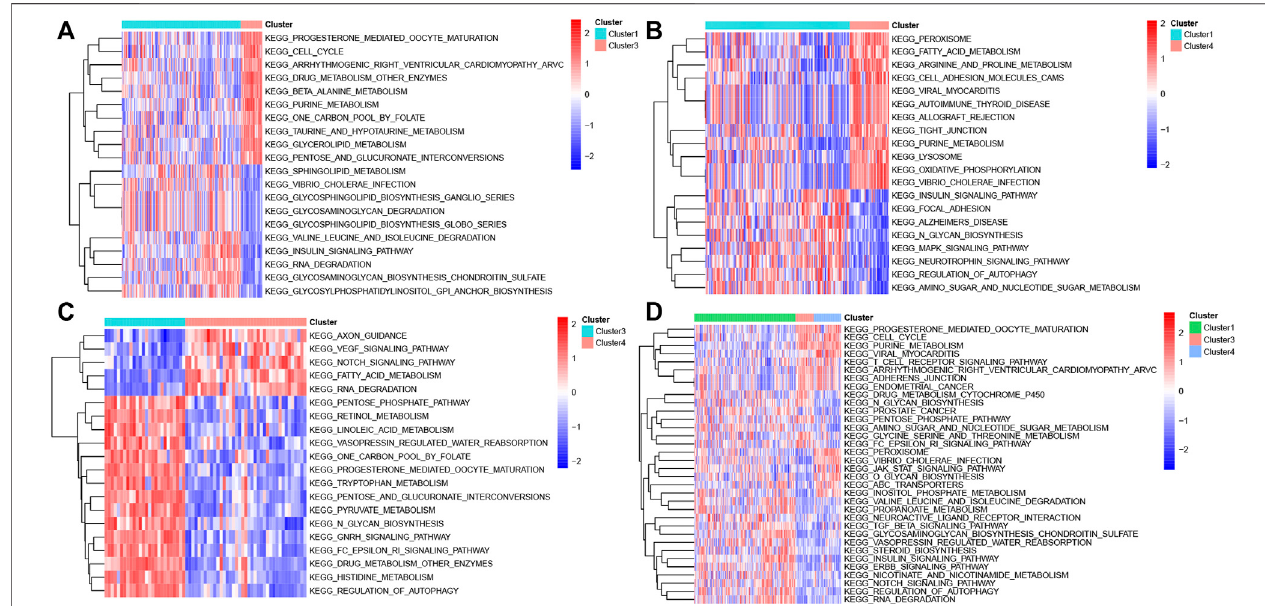
FIGURE 5 | GSVA analysis in different molecular subtypes of sepsis. (A) Representative heat map of the top 20 differentially enriched gene pathways between Cluster1 and Cluster3. (B) Representative heat map of the top 20 differentially enriched gene pathways between Cluster1 and Cluster4. (C) Representative heat map of thetop20differentiallyenrichedgenepathwaysbetweenCluster3andCluster4. (D) Representativeheatmapofthedifferentiallyenrichedgenepathwaysamongdistinct clusters.